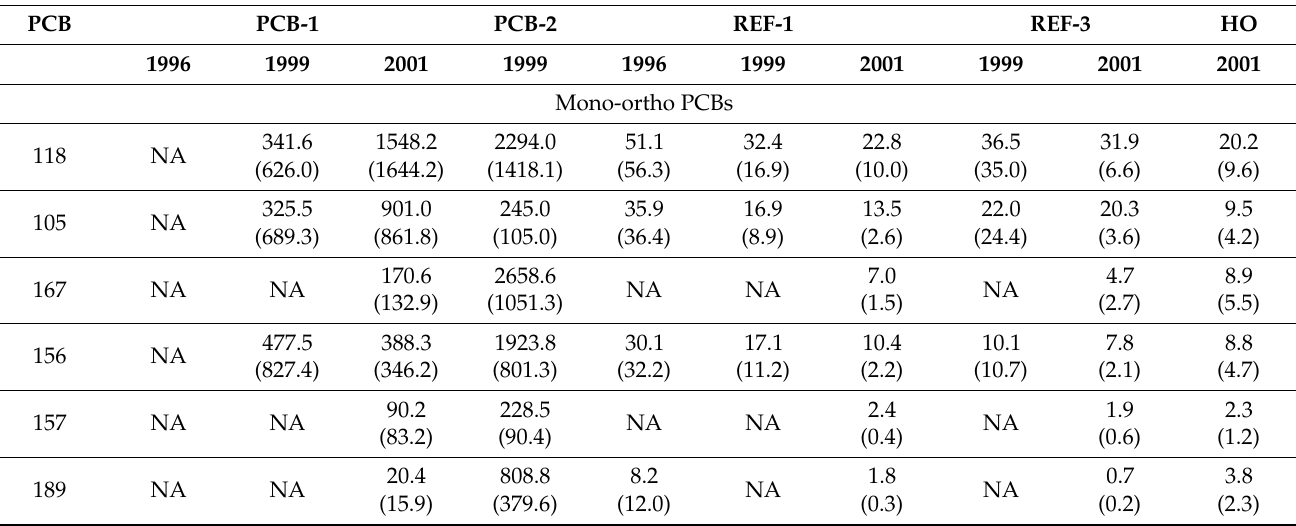
Table 8. Mean (SD) mono-ortho and non-ortho PCB congener concentrations in damselfish tissues from Johnston Atoll. For NDs, the lipid-normalized mean of one half of the detection limit is given. In 2001, dioxins and furans were also measured in fish tissue. Mean TCDD TEQs are given for